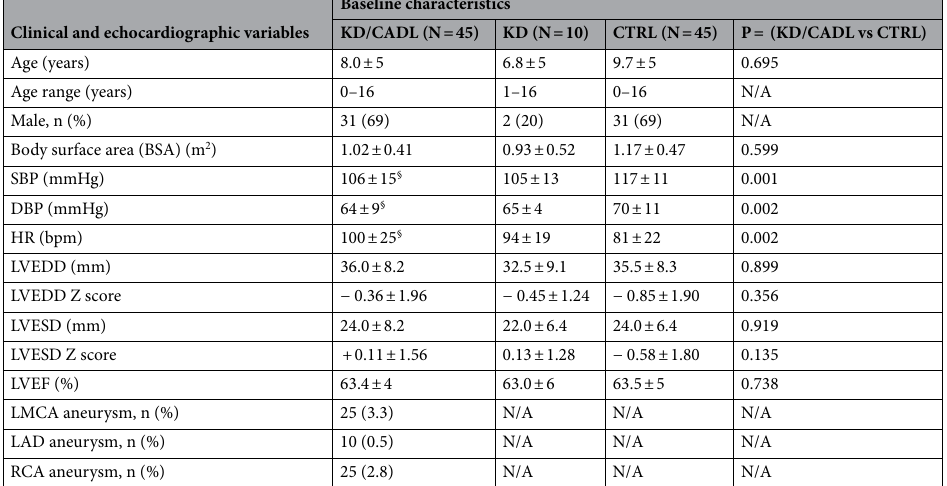
Table 1. Baseline characteristics of clinical and echocardiographic variables. Values are mean (SD), or n (%). KD/CADL group of children with Kawasaki disease and coronary aneurysms, KD group of children with Kawasaki disease without coronary aneurysms, LVEDD left ventricular end diastolic diameter, LVESD left ventricular end systolic diameter, LVEF left ventricular ejection fraction, BSA body surface area, HR heart rate, SBP systolic blood pressure, DBP diastolic blood pressure, LMCA left main coronary artery, LAD left anterior descending artery, RCA right coronary artery. § p < 0.05 compared to